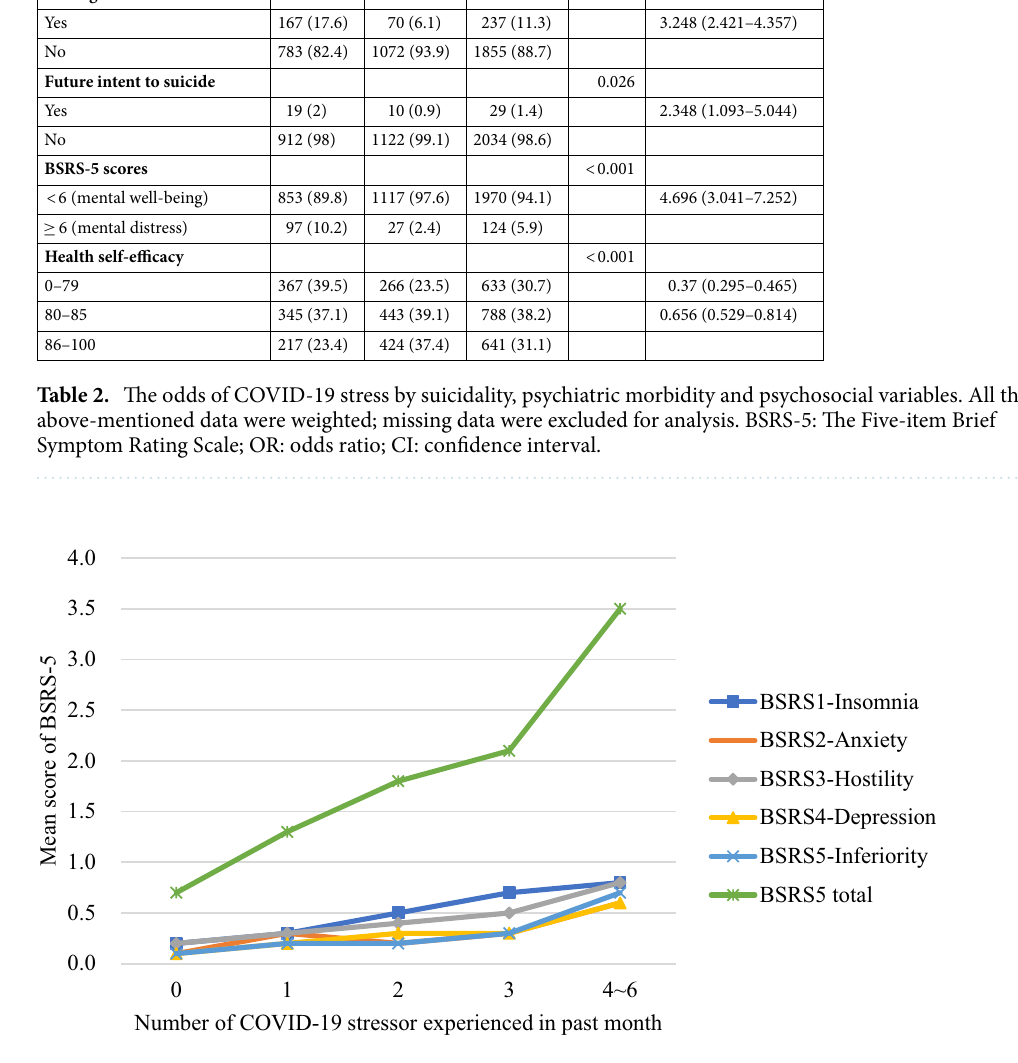
Figure 1. The association between psychological distress and the amount of reported COVID-19